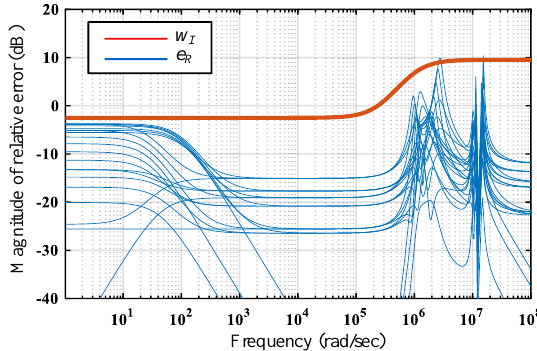
Figure 9. Relative error and w I.